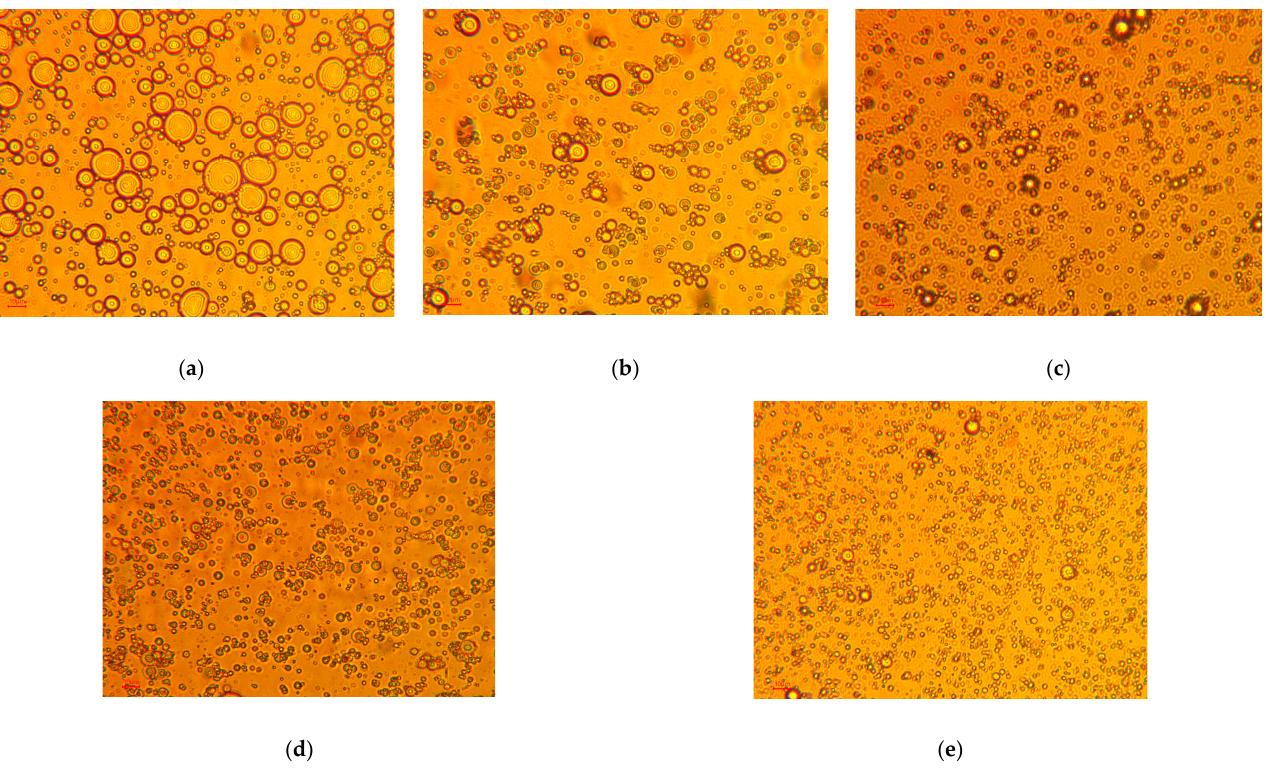
Figure 3. Optical microscopic images of lemongrass essential oil loaded emulsions stabilized by TEMPO-CNF at varying concentrations of ( a ) 0%, ( b ) 0.1 wt%, ( c ) 0.3 wt%, ( d ) 0.5 wt%, and ( e ) 0.7 wt% TEMPO-CNF. Note: All the scale bars are 10 µm.